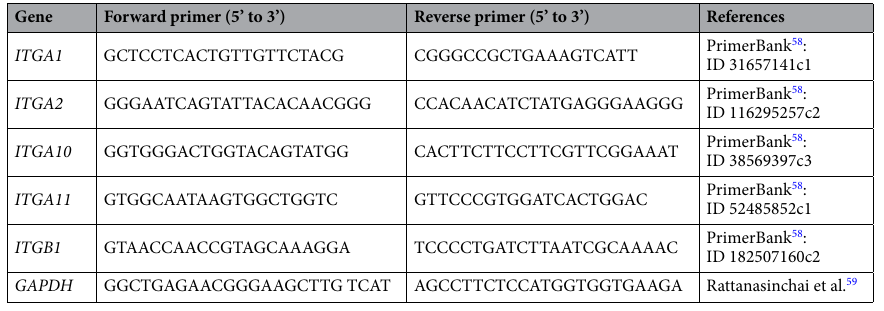
Table 1. List of